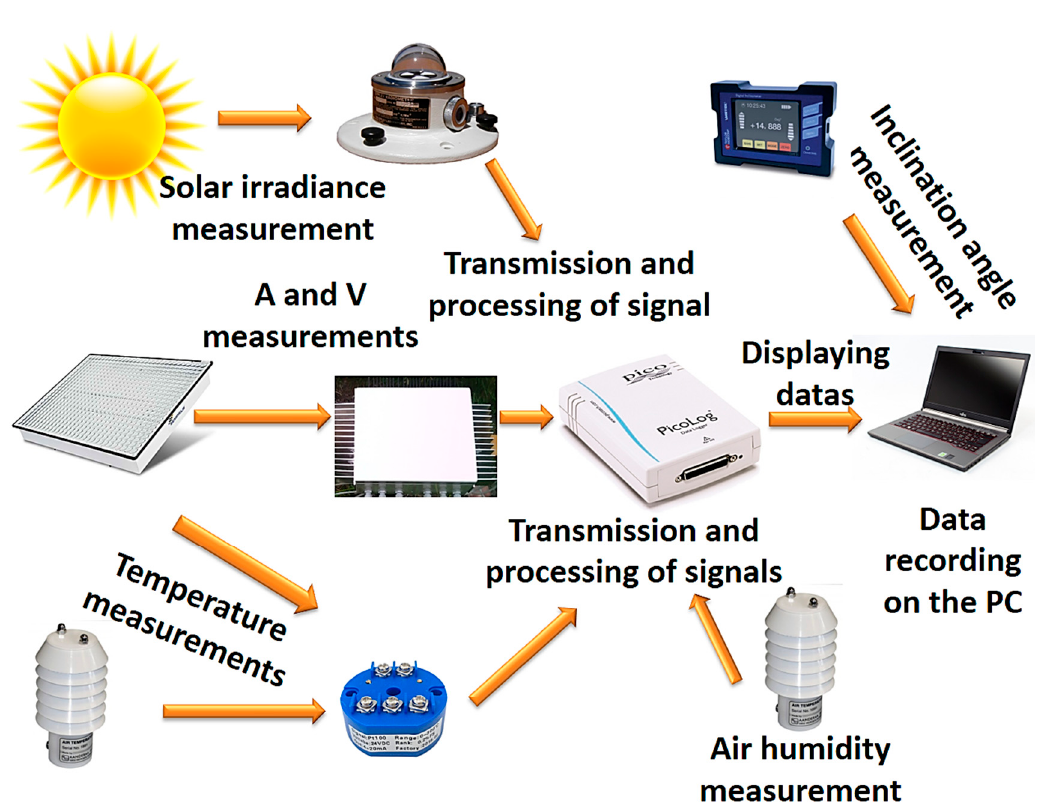
Figure 4. The configuration of PV module measuring station ‘A’.